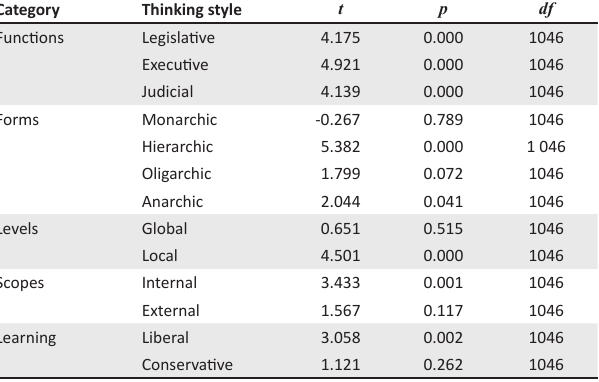
TABLE 6: The independent sample test of learners taking Mathematics and Mathematical Literacy and their different thinking styles.